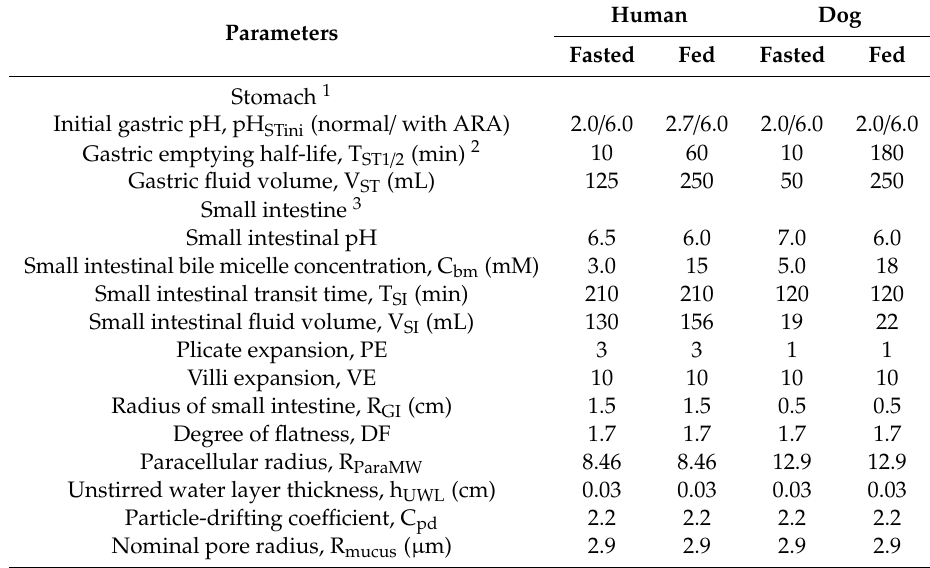
Table 1. Physiological